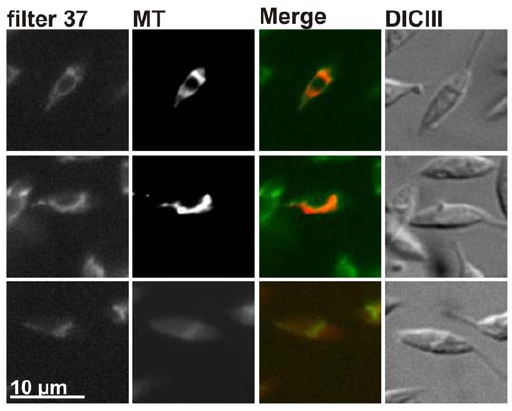
Figure 2. MitoTracker colocalization analyses. L. tarentolae promastigotes were stained with a MitoTracker dye before fixation with PFA and analysis by fluorescence microscopy. Slides were analyzed using a Zeiss Axiovert 200 M microscope and the software Axiovision. The autofluorescence was detected with the Zeiss filter set 37 (filter 37). MitoTracker staining was detected with the Zeiss filter set 20 (MT). Cells were visualized by differential interference contrast (DICIII). A XBO lamp served as a light